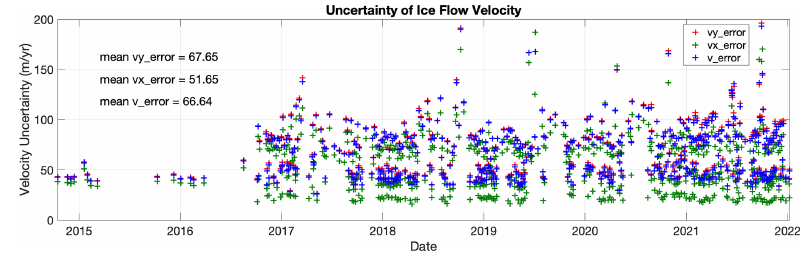
Figure 18. Uncertainty in ITS_LIVE Sentinel-1 image-pair velocities shown in Fig. 17 as provided in the product. The vx, vy and v uncertainties are calculated according to Eq. (3).